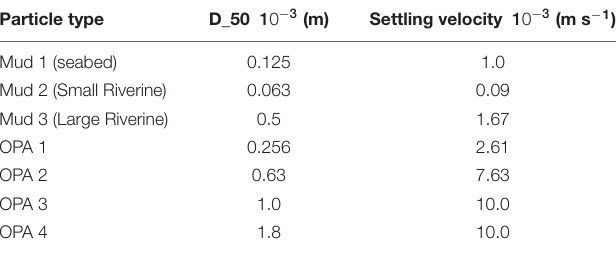
TABLE 3 | Properties of sediment and